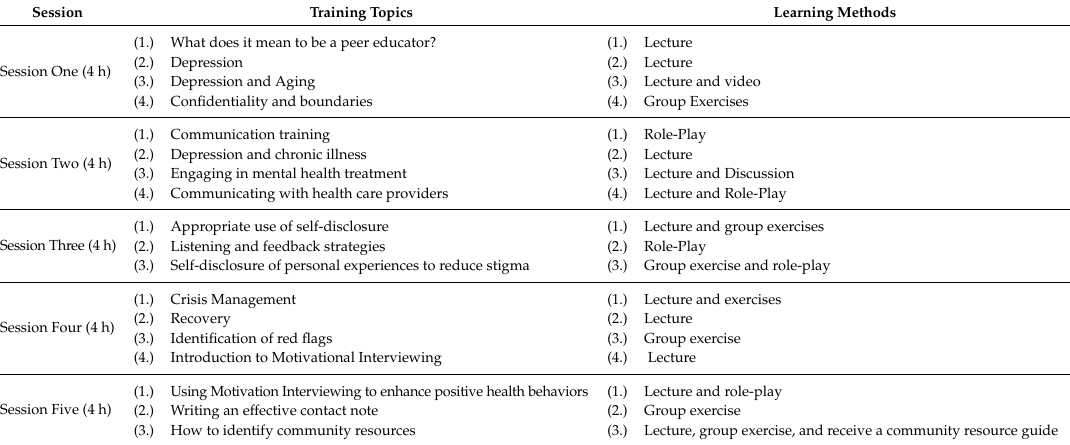
Table 1. Peer Educator Training